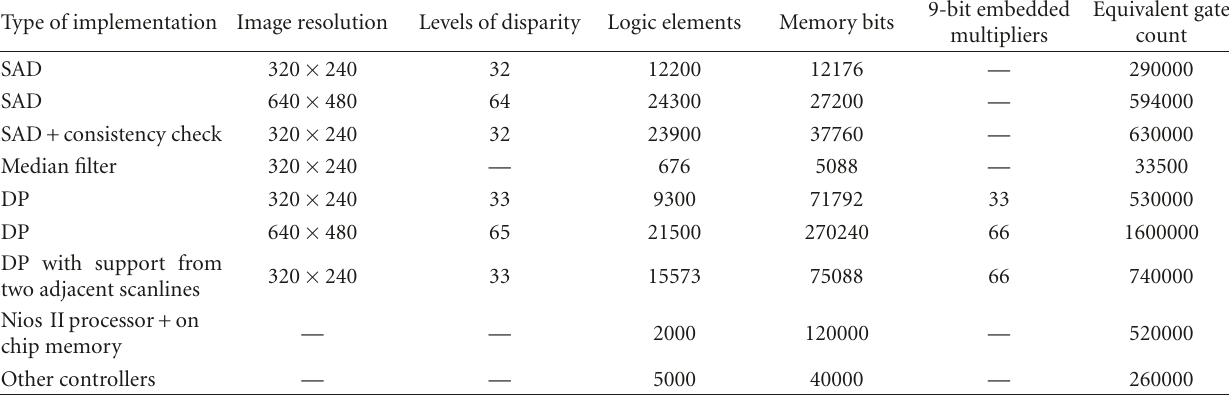
Table 2: Typical resources needed for implementing SAD and DP systems in